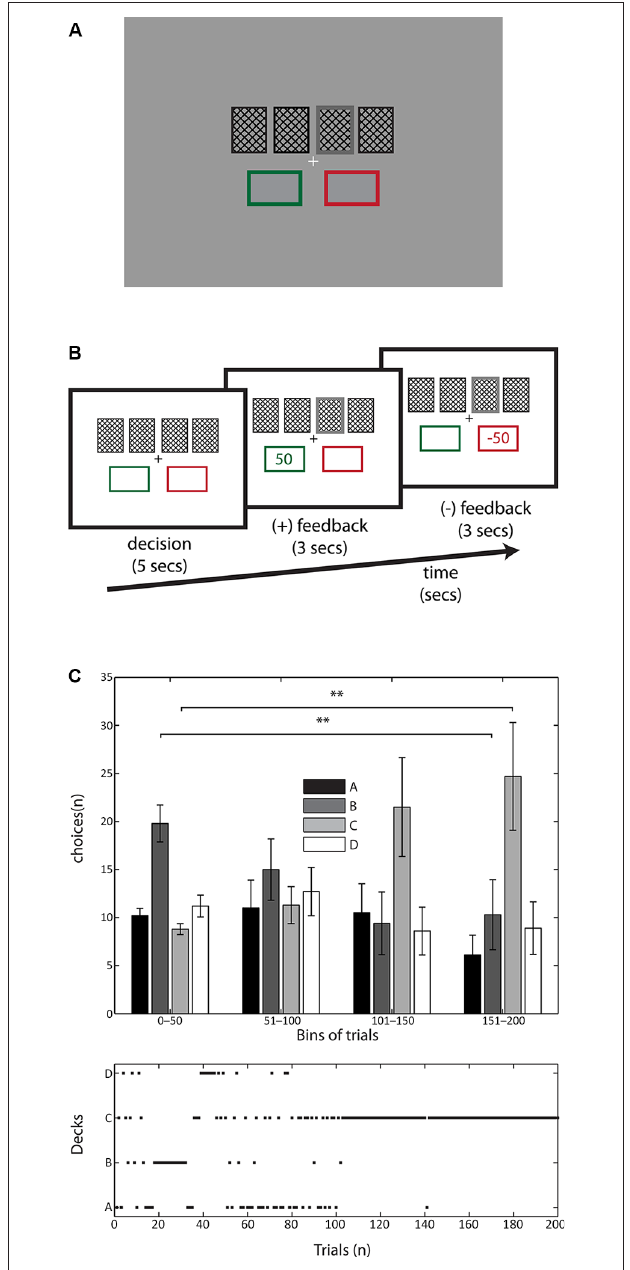
FIGURE 1 | Display depiction, trial timeline and behavioral results in IGT. (A) Schematic of the display. The colors of the stimuli were isoluminant to prevent pupil changes due to luminance, and the relevant stimulation was kept near the center of fixation in order to prevent saccades. The four decks were represented by cards presented 1 ◦ above the fixation cross. After a selection the card was highlighted (double line stroke and 80% gray, here depicted in deck 3). The two rectangles holding the positive (green outline) and negative (red outline) were kept during the whole trial. (B) A typical trial started with a fixation cross followed by the decision screen where the participants were asked to pick one of the four decks (5 s), immediately after the selection the chosen deck was highlighted and the PF was presented (3 s) followed for the NF (3 s). (C) Top: Temporal evolution of subjects’ choices across the experiment, trials were pooled in 50 trials’ bins. Note the interaction between time (trials) and deck